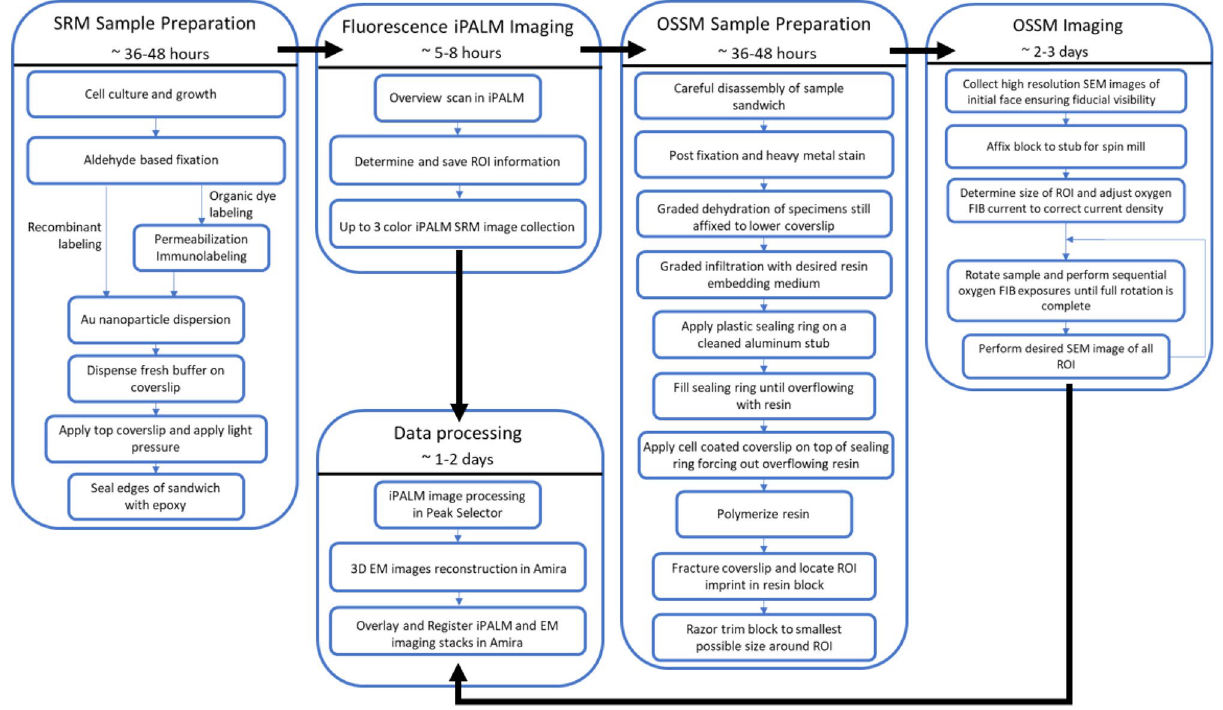
Figure 1. Quick-reference flowchart describing the correlative iPALM / OSSM workflow with time estimates for each phase of the workflow. Some data processing may be done in parallel to reduce the overall time to data by approximately one